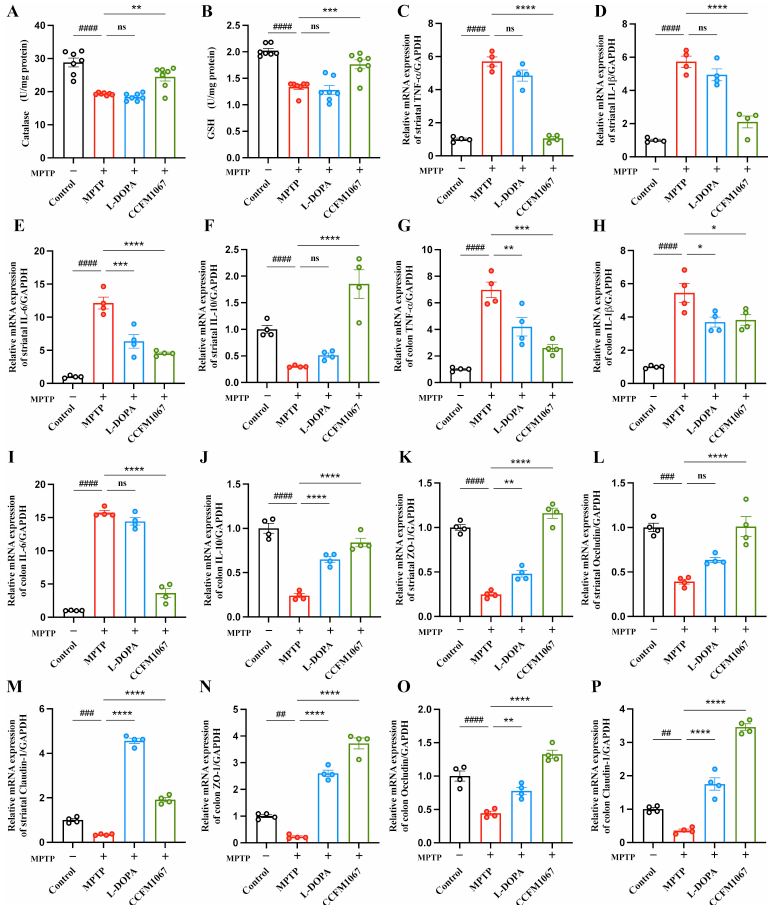
Figure 3. B. breve CCFM1067 reduced MPTP-induced oxidative stress, suppressed the generation of pro-inflammatory molecules in the SN and colon, and alleviated intestinal barrier damage. The antioxidant activities of catalase ( A ) and GSH ( B ) in the midbrain (U/mg protein) ( n = 7/group). ( C – J ) The mRNA expression of TNF- α, IL - 1β, IL -6 and IL-10 in the mouse midbrain and colon ( n = 4/group). ( K – P ) The mRNA expression of ZO-1, occludin, and claudin-1 in the midbrain and colon of mice ( n = 4/group). Data are means with SEM; ## p < 0.01, ### p < 0.001, #### p < 0.0001 vs. control group; * p < 0.05, ** p < 0.01, *** p < 0.001, **** p < 0.0001 vs. MPTP group, “ns” means there was no noticeable difference between the groups.